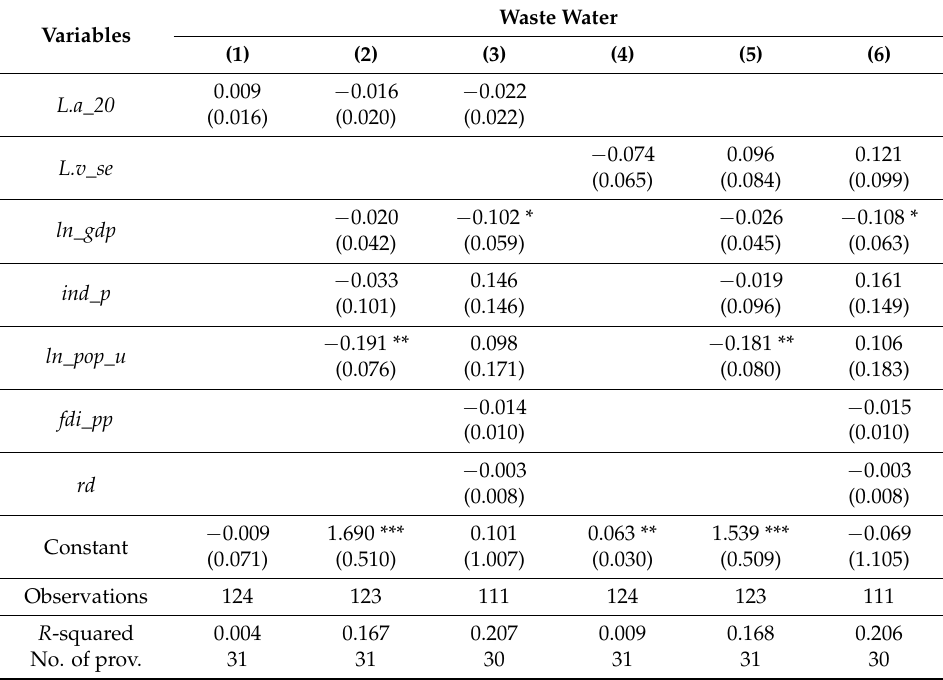
Table 7. Robustness check on the waste water governance response vis- à -vis public environmental dissatisfaction.